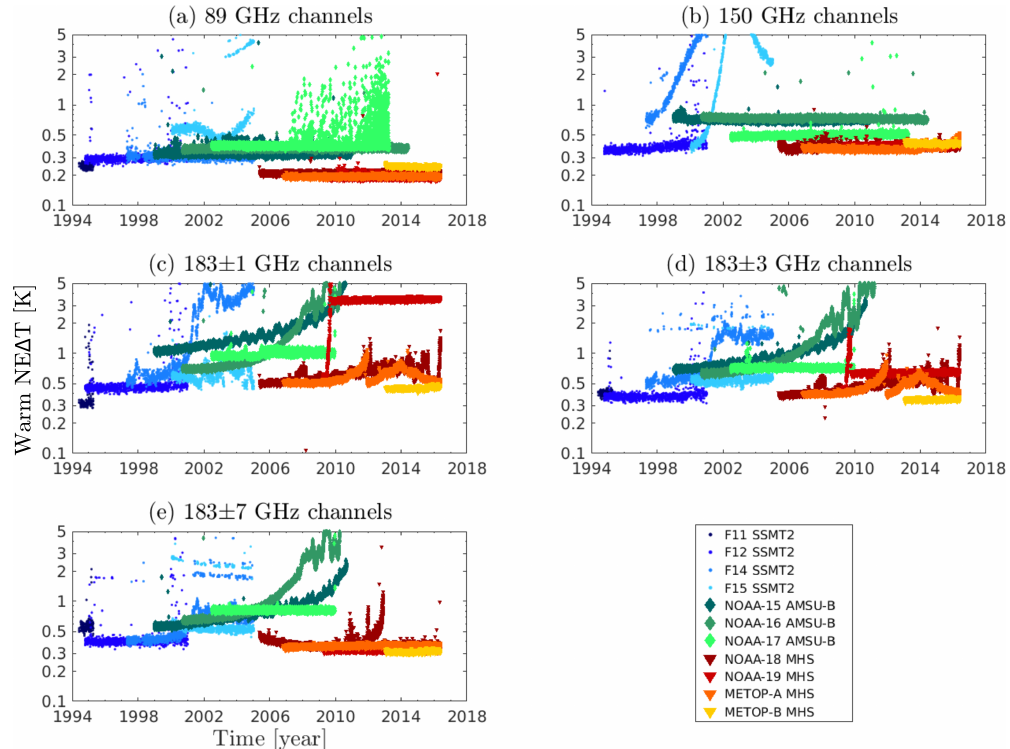
Figure 8. The time evolution of the warm NE (cid:49)T for the five frequency